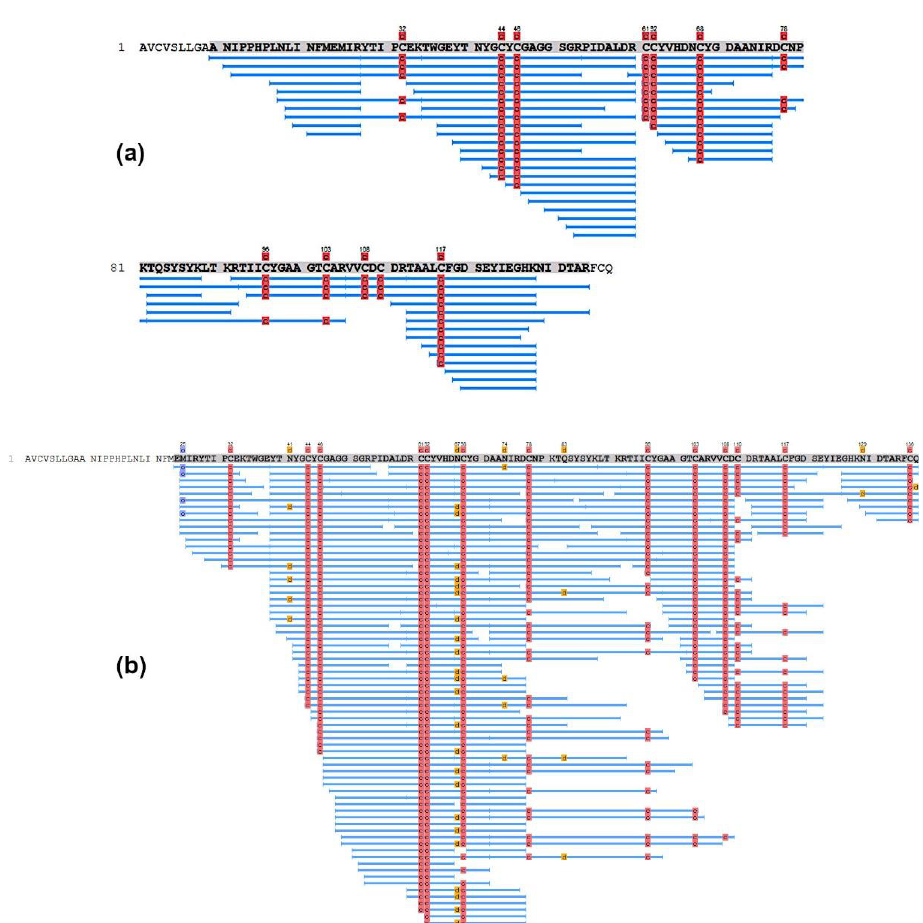
Figure 7. Peptide mass fingerprinting for the protein of fraction IV-18-2. The peptides found in tryp- tic ( a ) and Glu-C ( b ) digests and matching the shown amino acid sequence are indicated by blue lines. C on the red background shows carbamidomethylated cysteine residues, d on the yellow back- ground shows aspartic acid produced by deamidation of asparagine and o on the blue background — methionine sulfoxide. The amino acid sequence is for the A- chain (gi|6523113) precursors of β - Bgt.